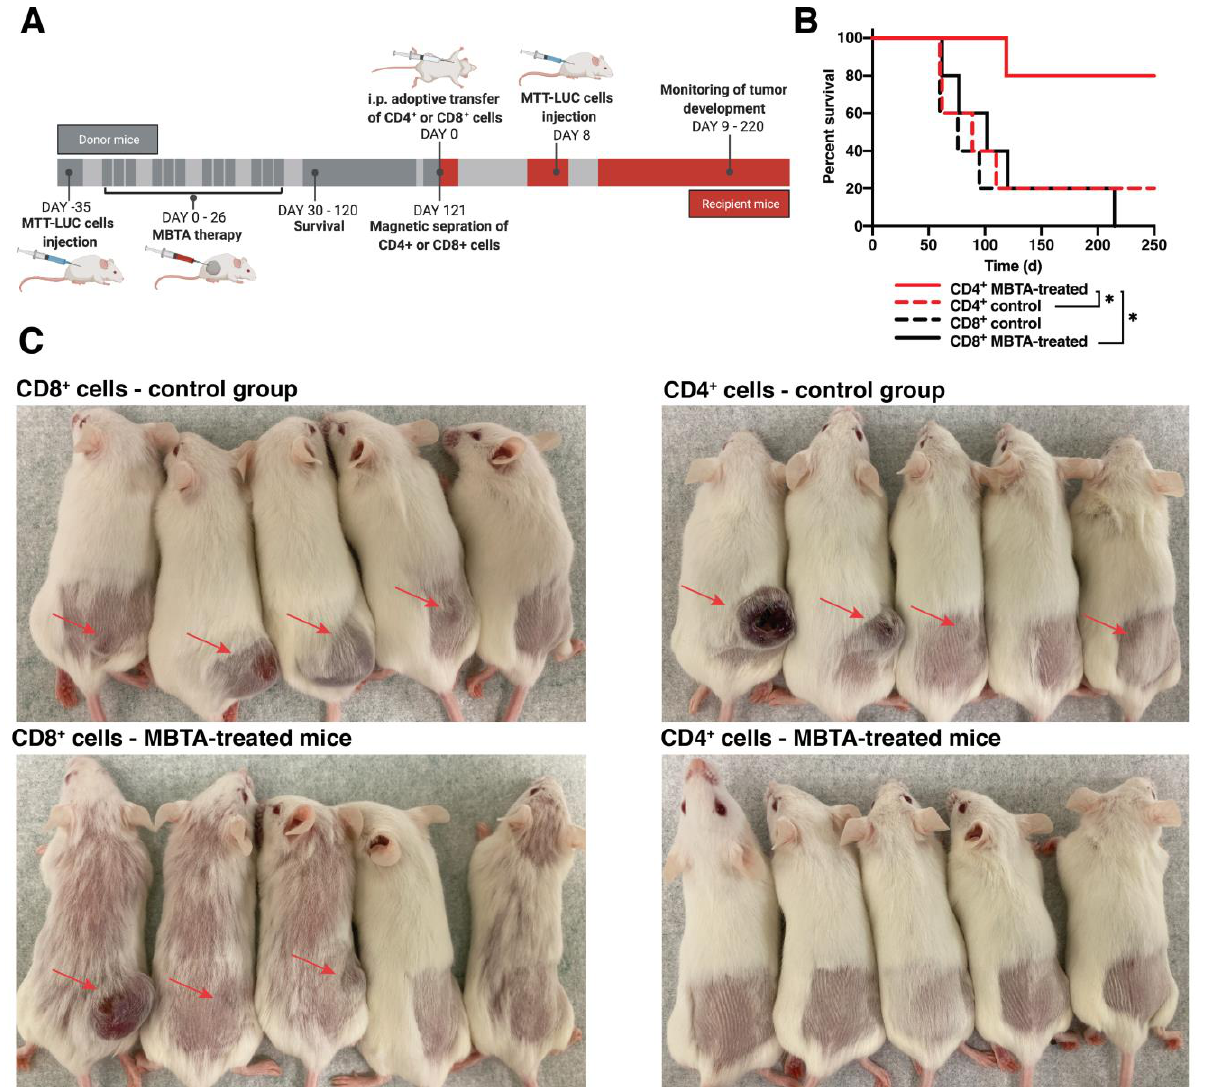
Figure 5. Adoptive transfer of CD4 + or CD8 + T cells. ( A ) Experimental design diagram of adoptive transfer. ( B ) The survival analysis is presented as a Kaplan-Meier curve ( n = 5 per group) (* p < 0.05). ( C ) Pictures of recipient mice taken after 60 days from the MTT-luc inoculation.